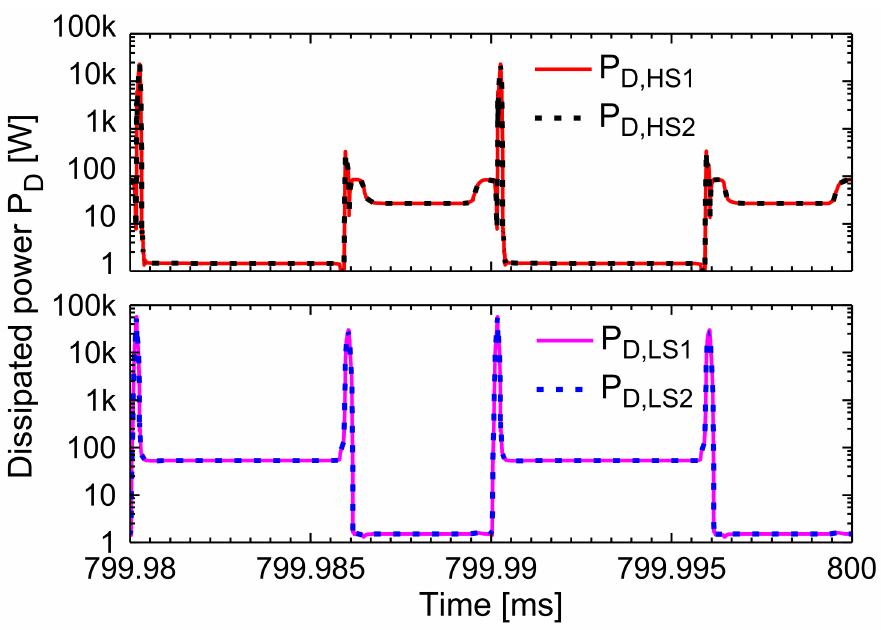
Figure 8. SIMetriX simulation of the macrocircuit representing the DC-DC converter: power dissi- pated by the four VDMOS transistors vs. time in a two-period-long window at the limit cycle; the top (bottom) curves show the values referred to HS (LS) devices.